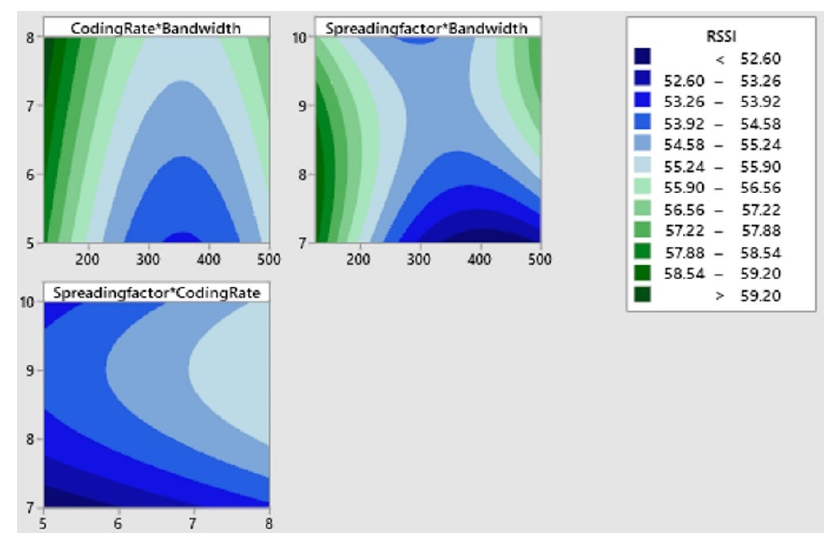
Figure 8. Contour graphs for settings evaluated in Experiment 1.